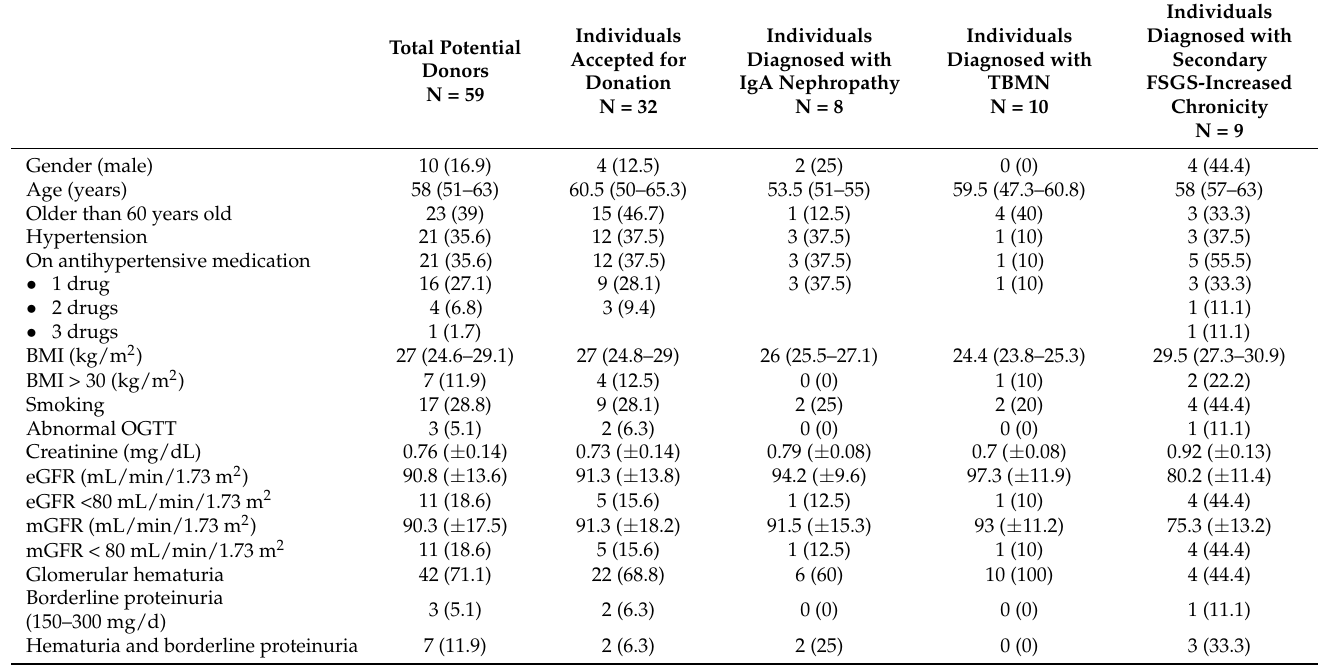
Table 2. Demographic and clinical characteristics of potential living kidney donors who underwent a kidney biopsy classified by diagnosis [N (%) or Mean ( ± SD) or Median (IQR)].